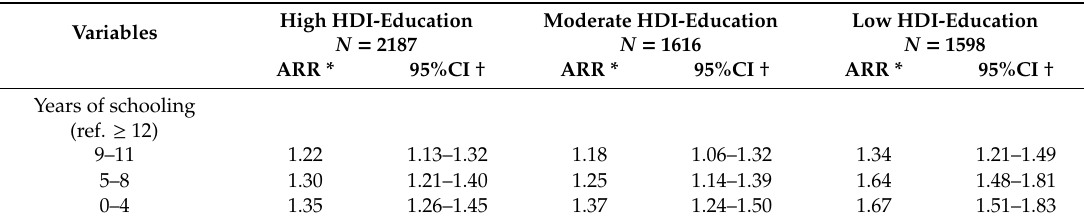
Table 6. Association between years of schooling and tooth loss among elderly people according to Human of Development Index education determined by multilevel negative binomial regression. High HDI-Education Moderate HDI-Education Variables N = 2187 N =